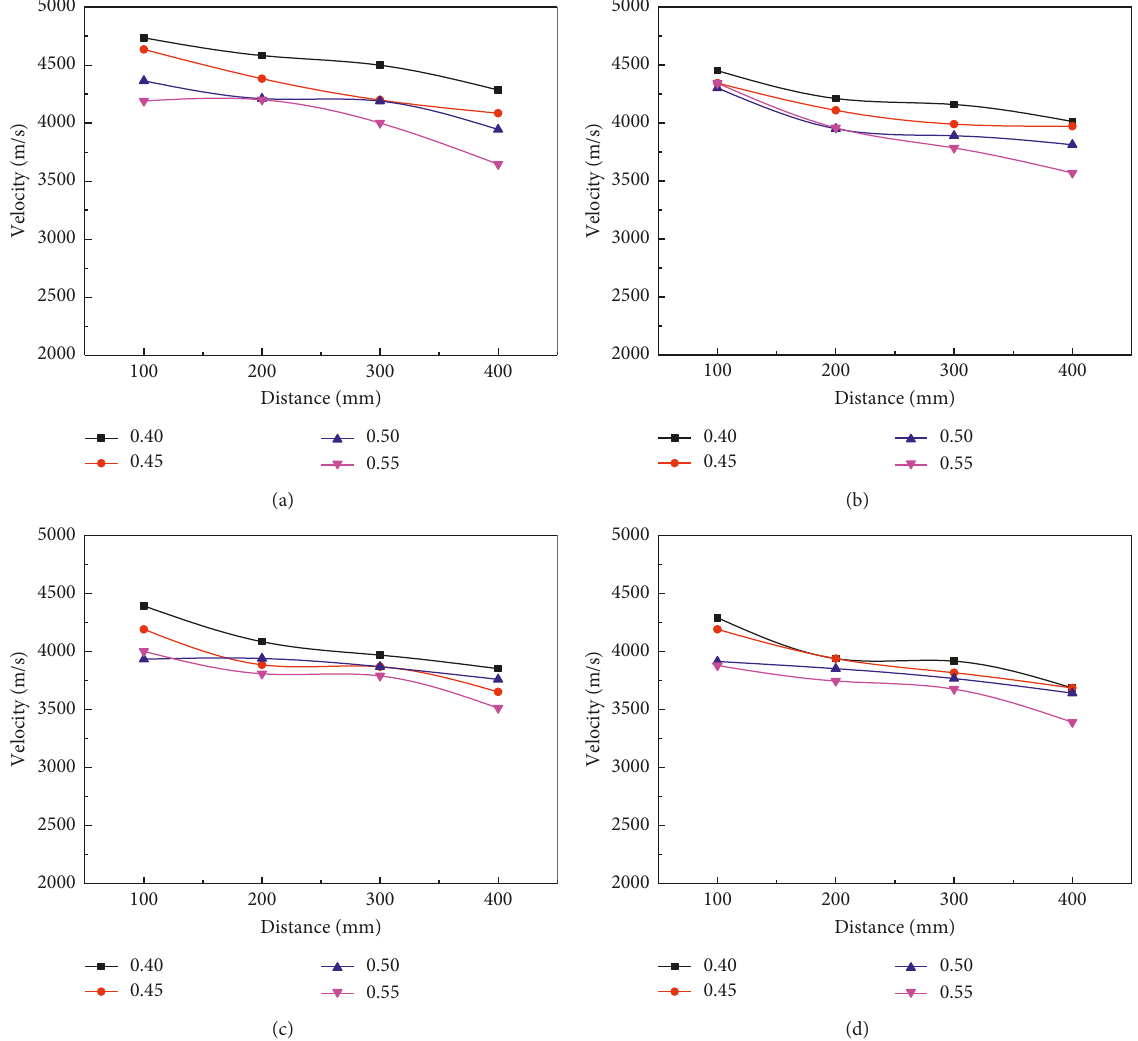
Figure 3: AE velocity with different distances under different water-cement ratios and the same aggregate size. Maximum aggregate size is (a) 4.75 mm, (b) 12.5mm, (c) 19mm, and (d)